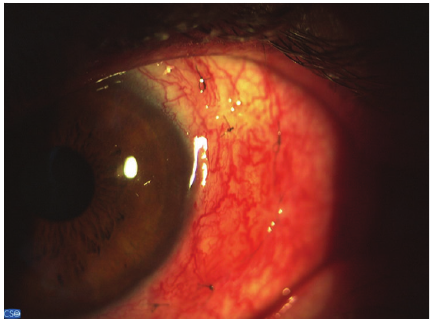
Figure1:Theconjunctivalautografttechniquewasperformedinthe first week after surgery.